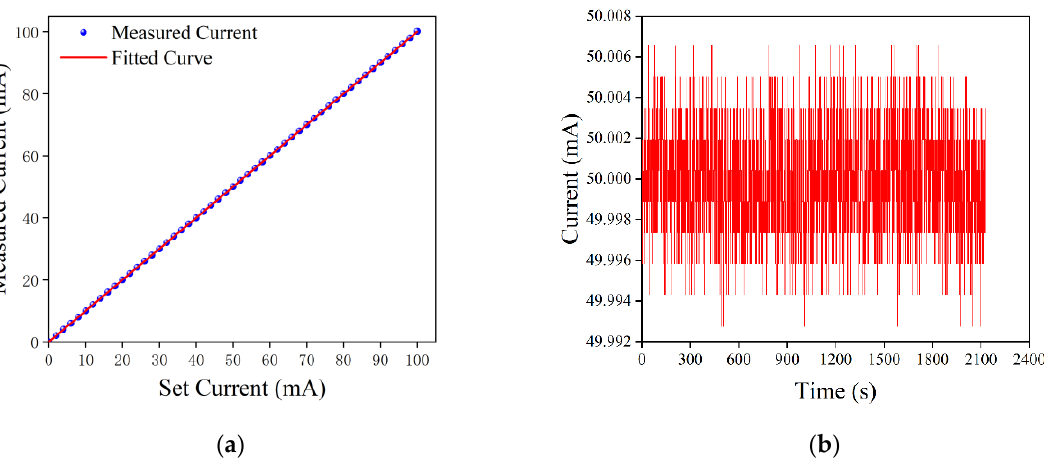
Figure 15. Test results of the drive current: ( a ) linearity of the drive current and ( b ) stability of the drive current.